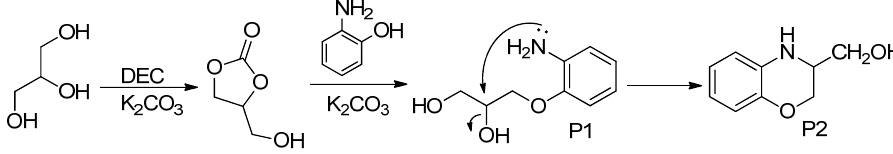
Scheme 1. Schematic representation of the reaction of 2-aminophenol and glycerol.